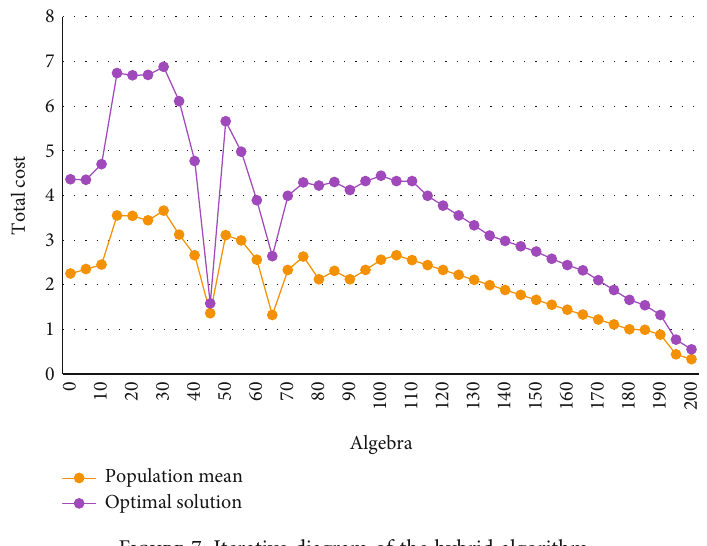
Figure 7: Iterative diagram of the hybrid algorithm.